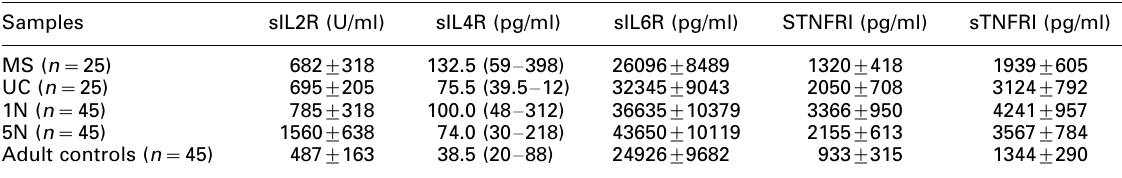
Data presented as mean 9 / standard deviation, or as mean A strong correlation was found between sIL6R concentrations in UC and 1N ( r (cid:3)